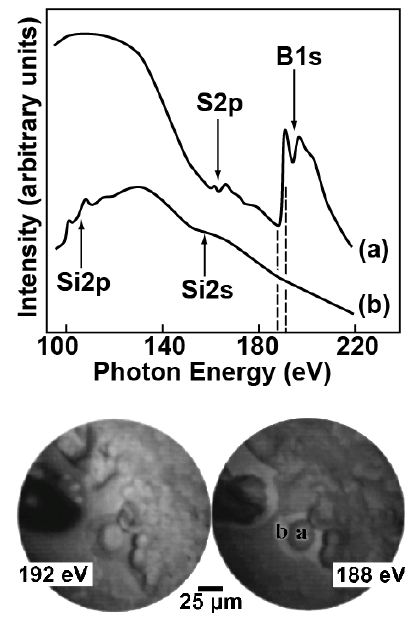
Figure 11. Top: surface optical absorption spectra obtained with the “partial yield” approach by Gudat and Kunz [19] and with high lateral resolution. The spectra were taken in the two areas “a” and “b” of the bottom images and correspond to a silicon substrate covered (“a”) or not (“b”) by BSH. The two images were obtained by exciting photoelectrons with two different photon energies right below and above the B1s threshold. Data from